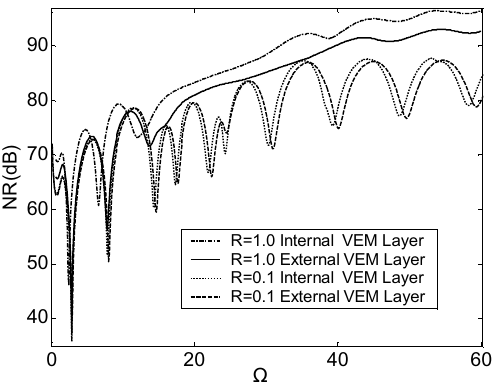
Fig. 11. Noise reduction obtained for the cylinder with the thicknesses of 10 mm using the VEM as an internal or external layer. internal or external layer on noise reduction is examined for thin and thick VEM layers. The noise reductions